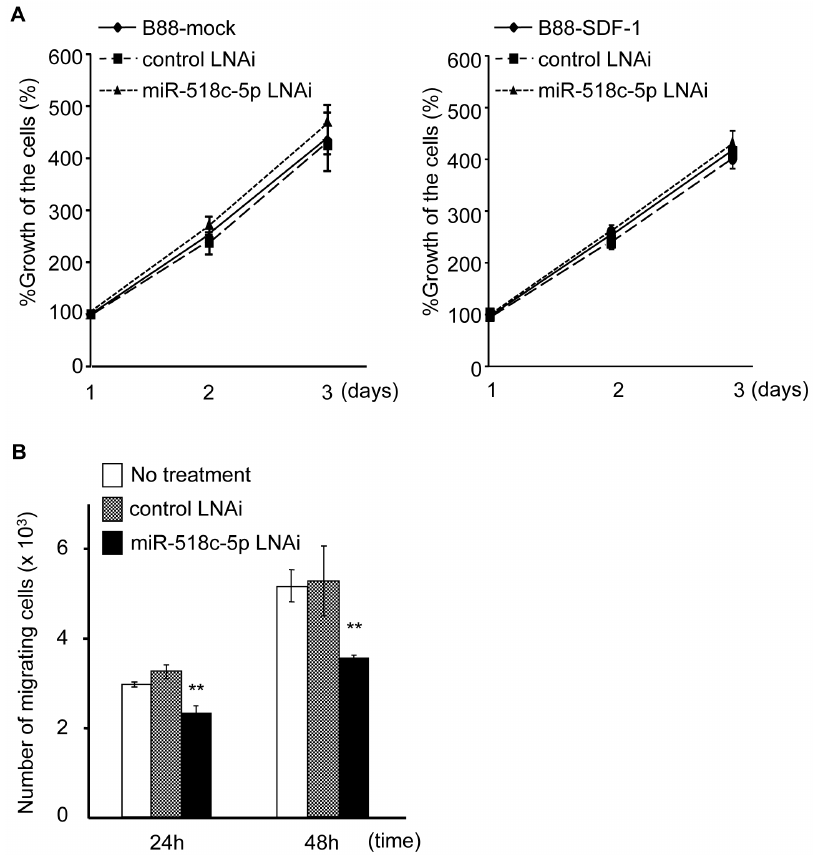
Fig. 2. The involvement of miR-518c-5p on SDF-1/CXCR4-dependent cell migration. (A) The growth of B88-mock cells (left side) and B88-SDF-1 cells (right side) in the presence of either a control LNA inhibitor or a miR-518c-5p LNA inhibitor was examined using an MTTassay. There were no significant differences between the three groups by one-way ANOVA. (B) The motility of B88-SDF-1 cells in the presence of either a control LNA inhibitor or a miR-518c-5p LNA inhibitor was examined using a Transwell migration assay. A total of 2 6 10 4 cells were transfected before being seeded in the chamber. **; p , 0.01 when compared to untreated control or control LNA inhibitor-treated cells by one-way